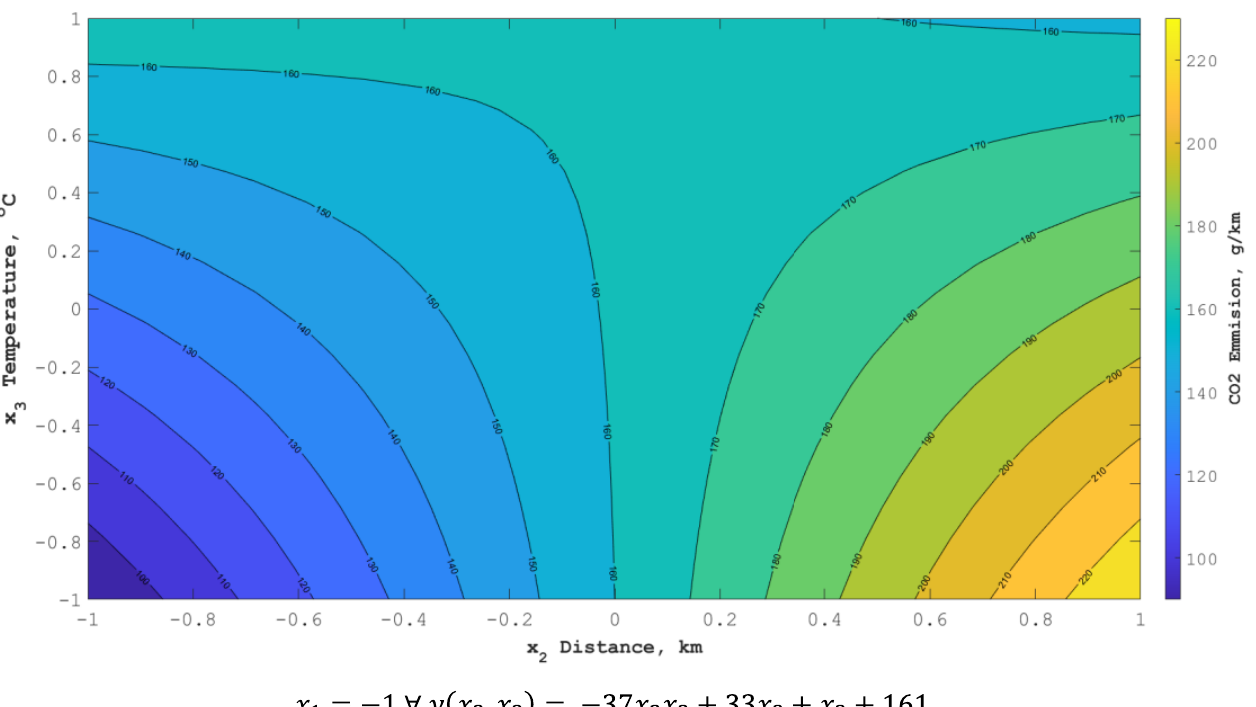
Figure 2. Change in CO 2 emissions depending on the variability of factors x 2 and x 3 for a vehicle (ICE) moving for 30 min (x 1 = −1 ).